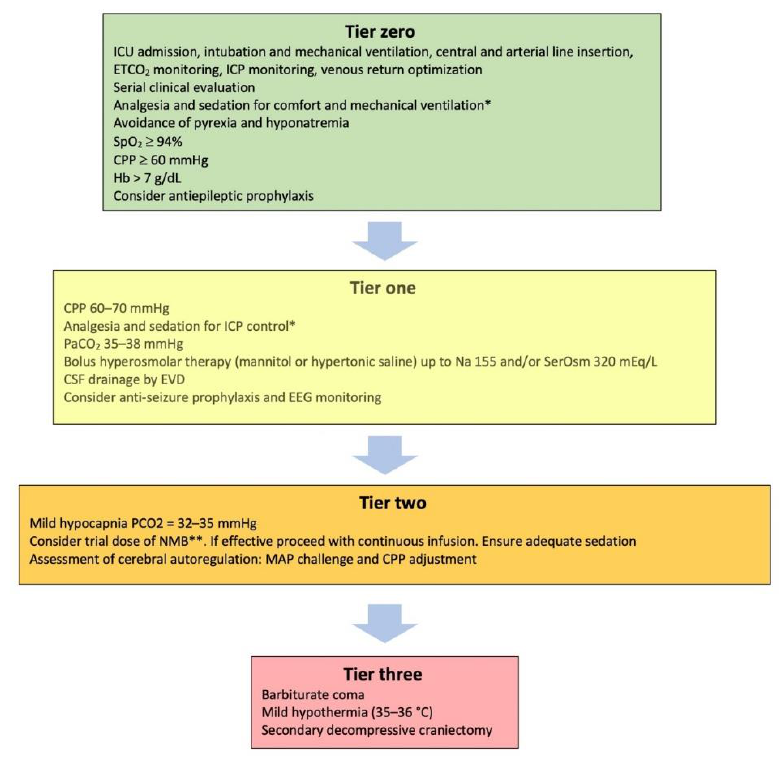
Figure 1. Treatment modalities included in the tiered approach for the management of intracranial hypertension. ICU: intensive care unit; ETCO 2 : end-tidal carbon dioxide partial pressure; ICP: intracranial pressure; SpO 2 : oxygen saturation; CPP: cerebral perfusion pressure; Hb: hemoglobin concentration; SerOsm: serum osmolality; CSF: cerebrospinal fluid; EVD: external ventricular drain; EEG: electroencephalography; NMB: neuromuscular blocker; MAP: mean arterial pressure. * Propofol